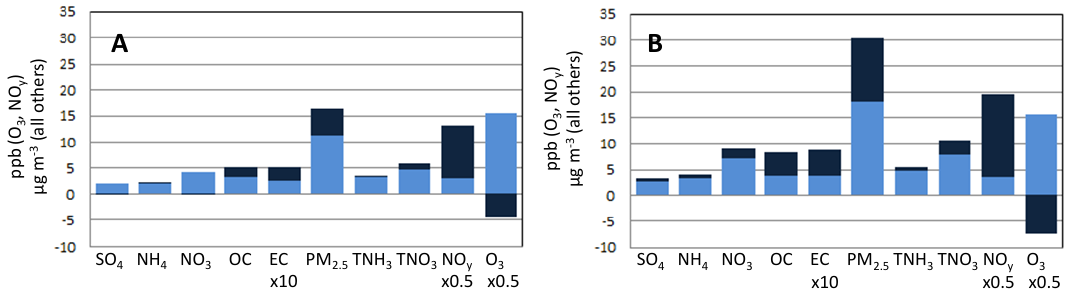
Fig. 13. Urban excess. Gas and inorganic aerosol species measured from continuous monitors and organic aerosol from integrated measurements are graphed. Light bars correspond to the rural site of the pair, and the dark increment is the urban excess. Ozone has an urban deficit rather than urban excess. Panel (A) is for all study hours, panel (B) is for periods when episodes occurred at both Milwaukee and Mayville. Note the change of scale for EC, NO y and O 3